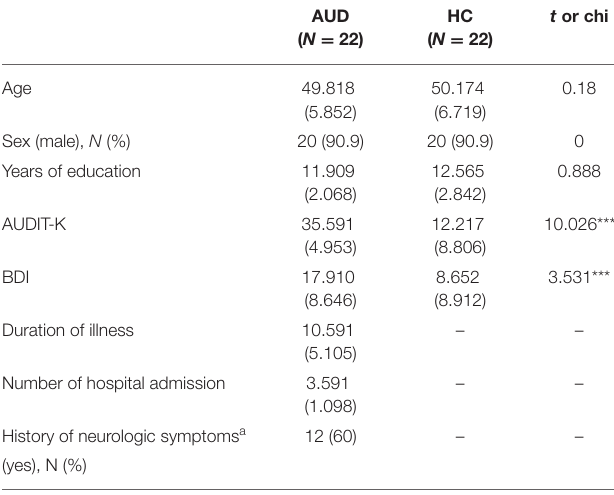
TABLE 1 | Demographic and clinical characteristics of the AUD and HC